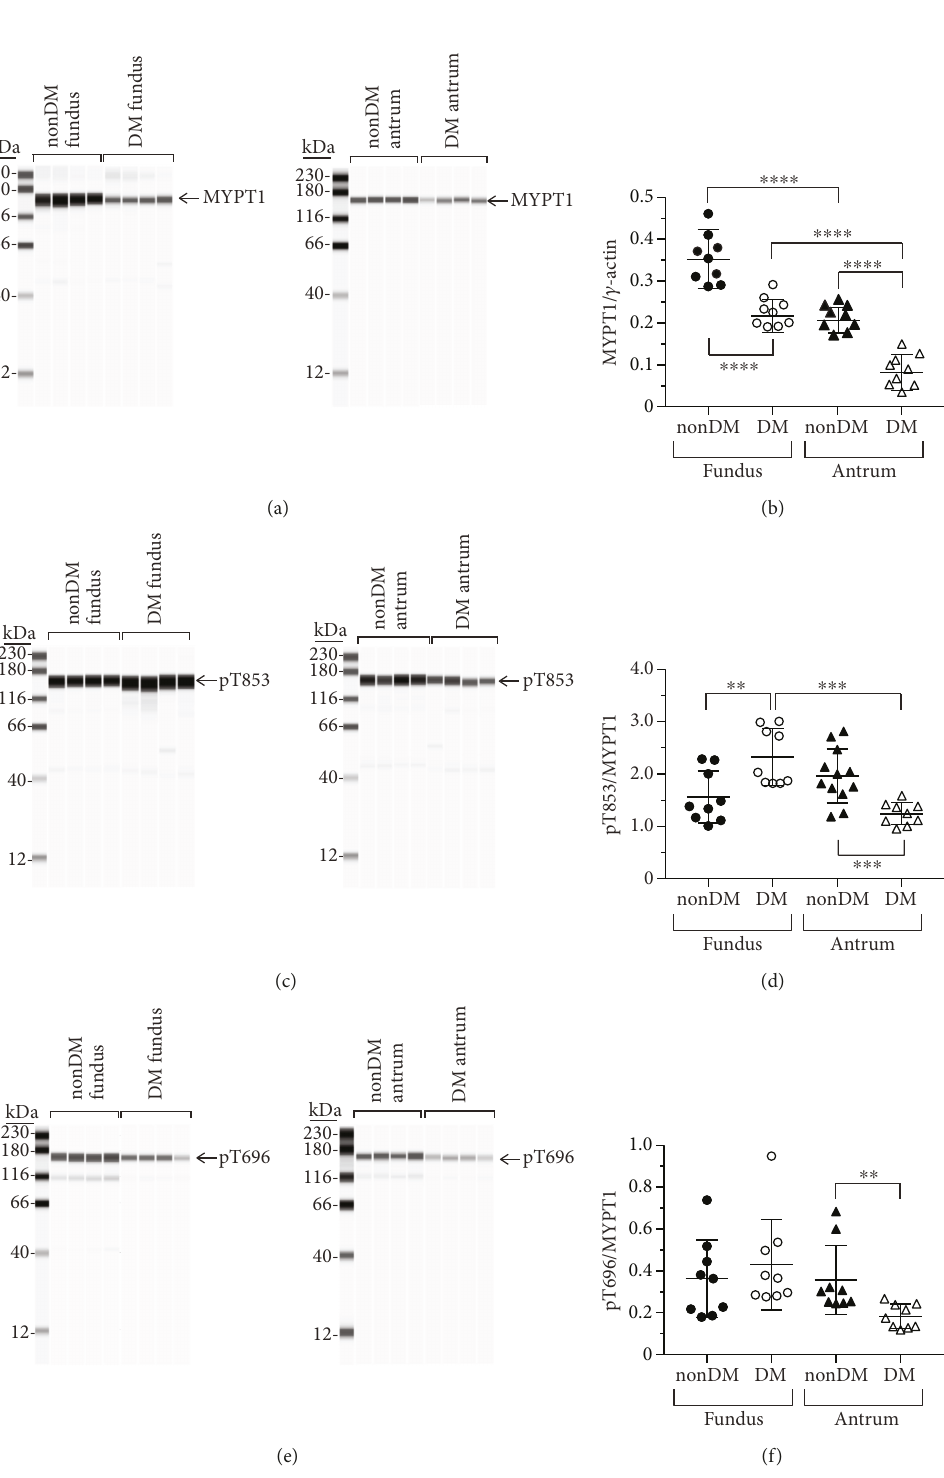
Figure 3: MYPT1 expression and T853 phosphorylation in nondiabetic and diabetic gastric fundus and gastric antrum smooth muscles. (a) Representative immunoblots of MYPT1 expression in nondiabetic and diabetic fundus (left panel, n = 4 , each group) and nondiabetic and diabetic antrum muscles (right panel, n = 4 , each group), 1 μ g muscle lysate per lane. (b) MYPT1 expression relative to enteric γ -actin expression in nondiabetic and diabetic fundus and antrum smooth muscles. (c) Representative immunoblots of phosphorylated T853 in nondiabetic and diabetic fundus (left panel, n = 4 , each group) and nondiabetic and diabetic antrum muscles (right panel, n = 4 , each group), 1 μ g muscle lysate per lane. (d) T853 phosphorylation relative to MYPT1 expression in nondiabetic and diabetic fundus and antrum smooth muscles. (e) Representative immunoblots of phosphorylated T696 in nondiabetic and diabetic fundus (left panel, n = 4 , each group) and nondiabetic and diabetic antrum muscles (right panel, n = 4 , each group), 1 μ g muscle lysate per lane. (f) T696 phosphorylation relative to MYPT1 expression in nondiabetic and diabetic fundus and antrum smooth muscles. ∗∗ P < 0 01 , ∗∗∗ P < 0 001 , and ∗∗∗∗ P < 0 0001